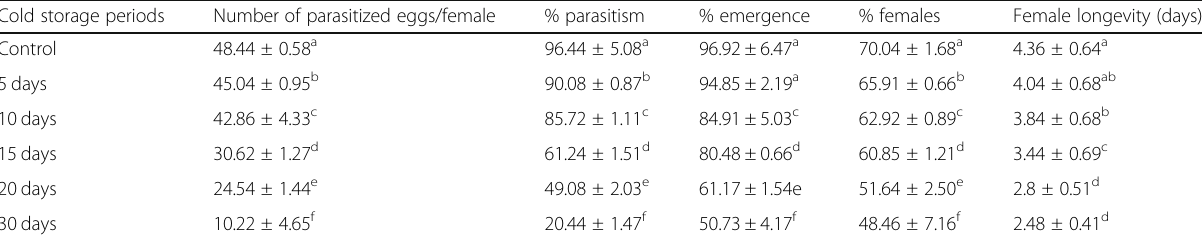
Table 1 Effect of using cold-stored S. cerealella eggs on the efficacy of Trichogramma evanescens Cold storage periods